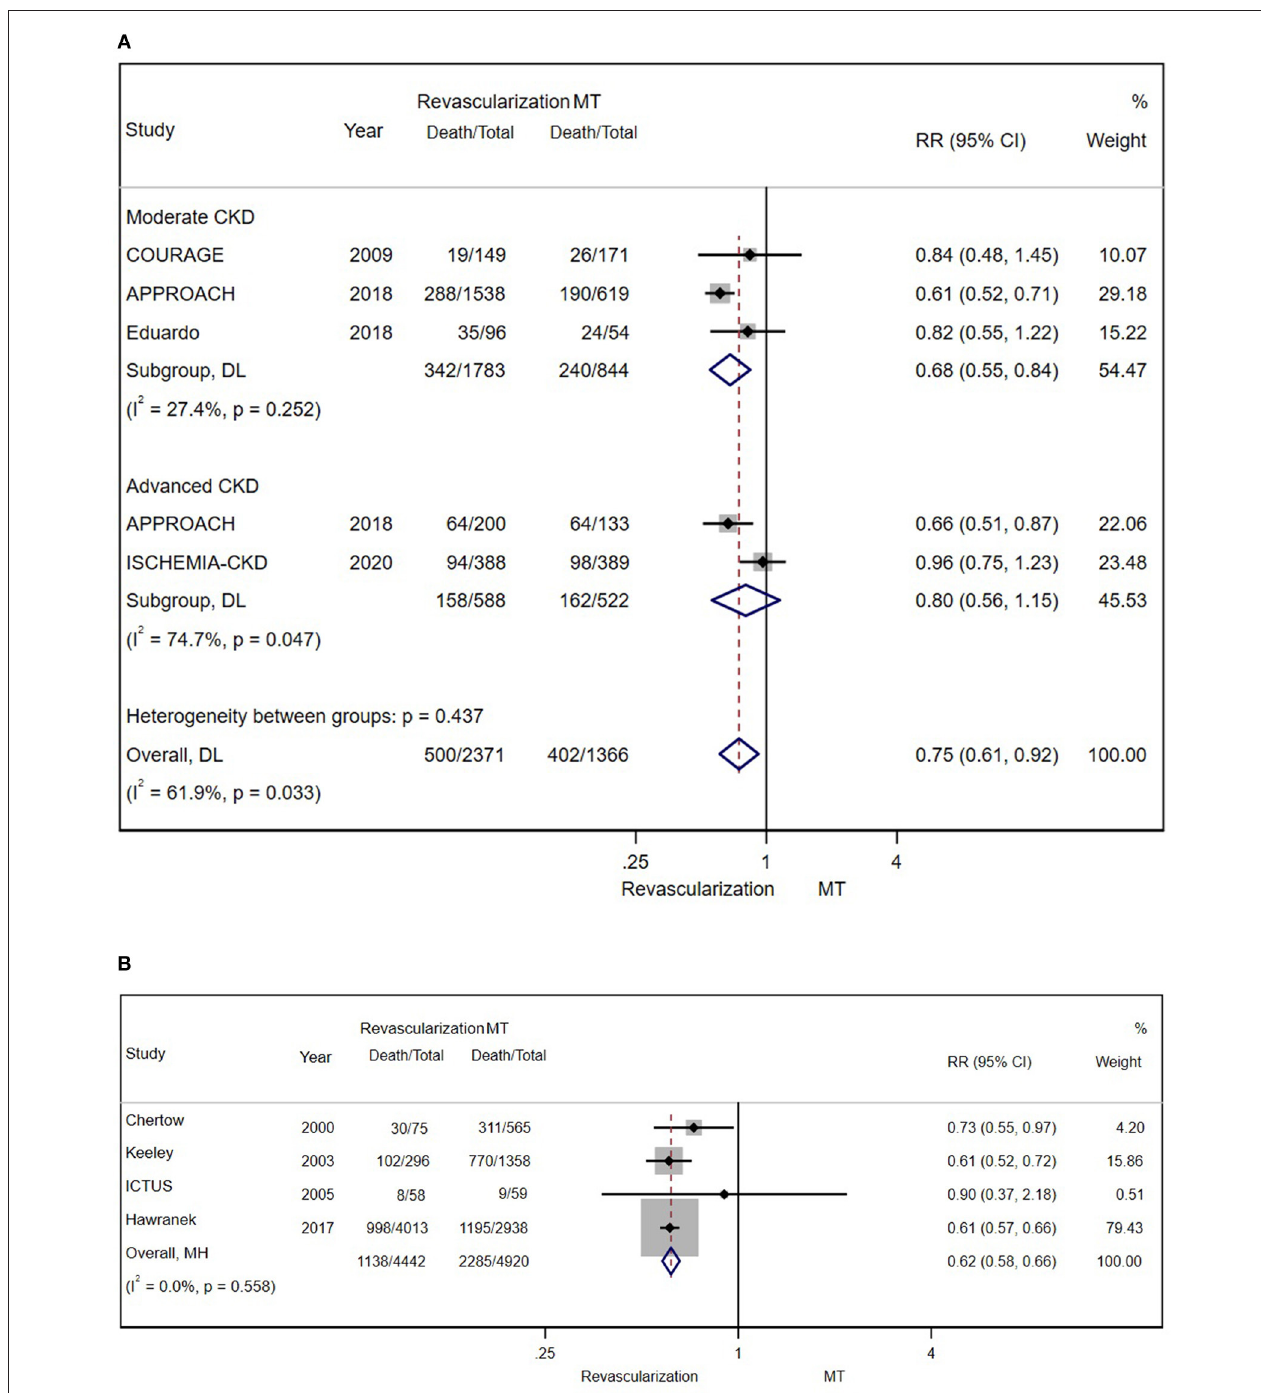
FIGURE 5 | (A) The pooled effect of revascularization and MT alone on the long-term mortality of stable patients with CAD and CKD. Compared with MT alone, revascularization was more effective in decreasing mortality. Weights and between-subgroup heterogeneity test are from random-effects model. (B) The pooled effect of revascularization and MT alone on the long-term mortality of patients with ACS and CKD. Compared with MT alone, revascularization was more effective in reducing mortality. Weights and between-subgroup heterogeneity test are from Mantel-Haenszel model.